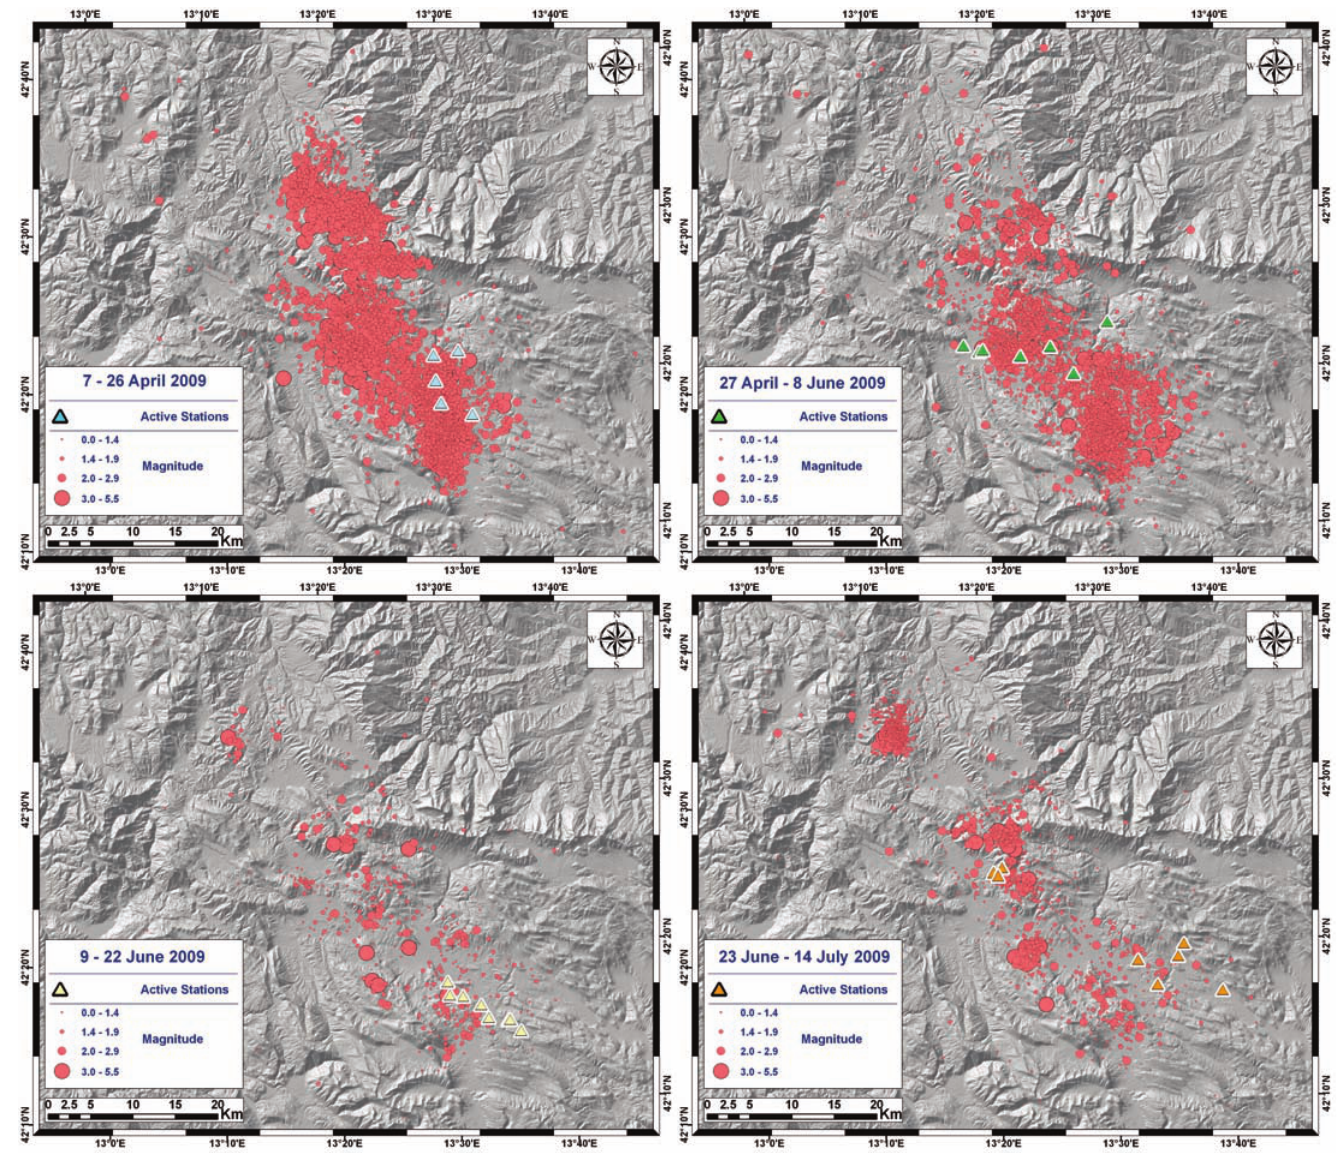
Figure 2. The RAIS-TS recorded events. Each panel shows the seismicity and the station distribution for each period considered (as